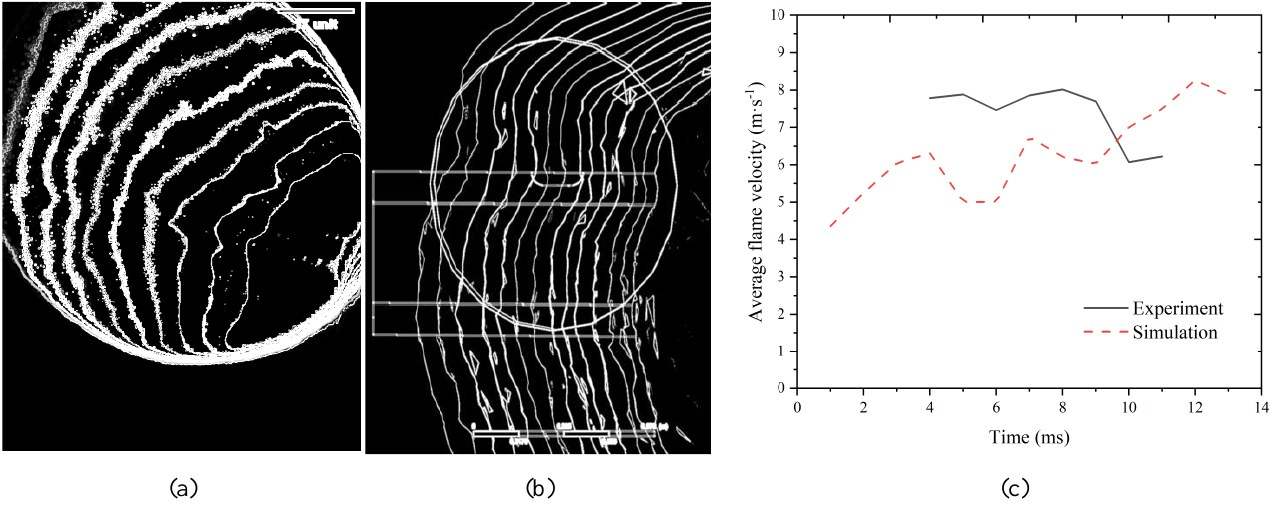
Figure 3. Comparison of the simulated and experimental results: ( a ) experimental flame front positions; ( b ) simulated flame front positions; ( c ) comparison of average flame velocity.